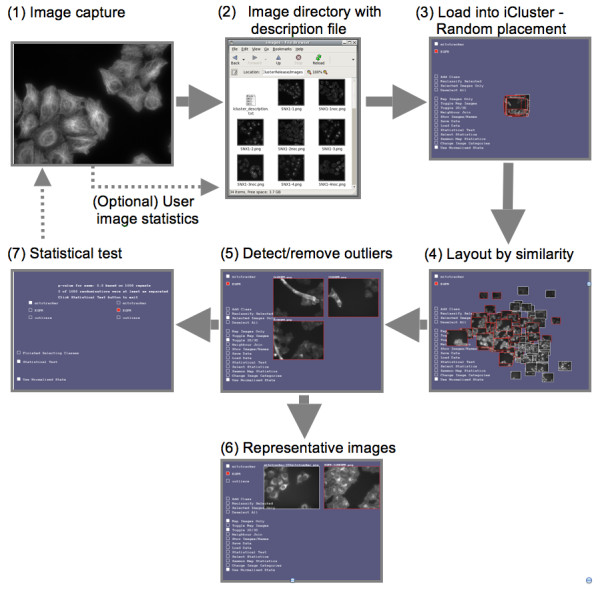
iCluster workflow to test for difference in imaging. (1) Treated/untreated sets of images are captured using identical microscope settings. (2) Images are stored in a directory together with a simple text format file describing which experiment each image belongs to. (3) The image description file together with the images is loaded into iCluster via a file selector. If (optional) image statistics have not been supplied by the user in the description file, TAS are generated automatically. Initially images are randomly placed in 3D. (4) The user initiates spatial layout by statistical similarity by clicking on 'Sammon Map'. (5) Once layout has finished, outlier images are found, viewed in detail, reclassified as 'Outliers', and removed from view. (6) Representative images for each experiment are automatically found and viewed in detail. (7) p-values are then calculated for the null hypothesis: no shift in localisation has occurred. For experiments where a large number of treatments are imaged, an initial test run on one or more treatments might be used to determine a minimum number of images required to detect difference. See also Supplementary Movie.